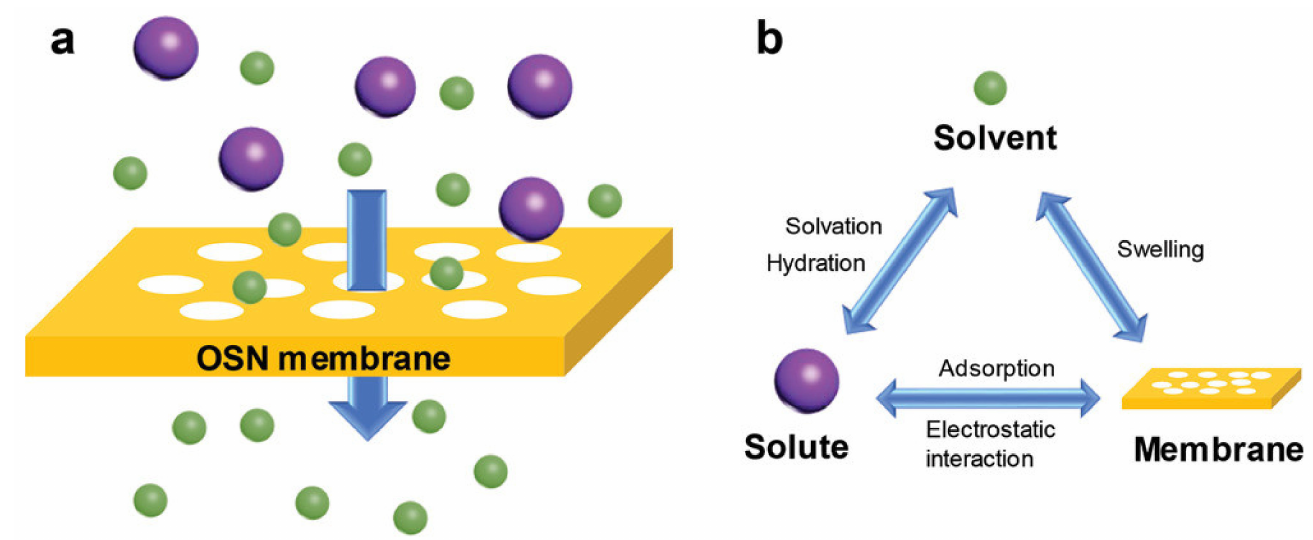
Figure 2. ( a ). Schematic representation of sieve effect based OSN membrane separation. ( b ). Inter- actions between membrane-solvent-solute. Reprinted and adapted with permission from Ref.